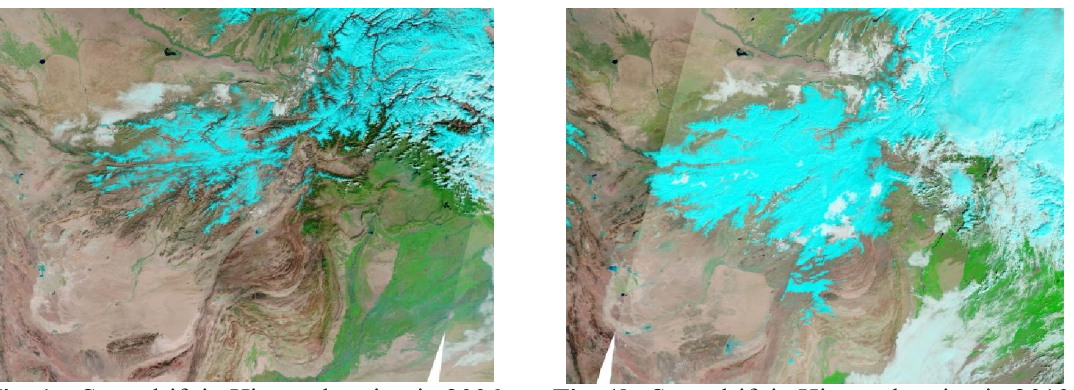
Fig. 1a. Snowdrift in Hirmand region in 2006 Fig. 1b. Snowdrift in Hirmand region in 2010 Fig. 2. Snowdrift in Hirmand region in 2006 and